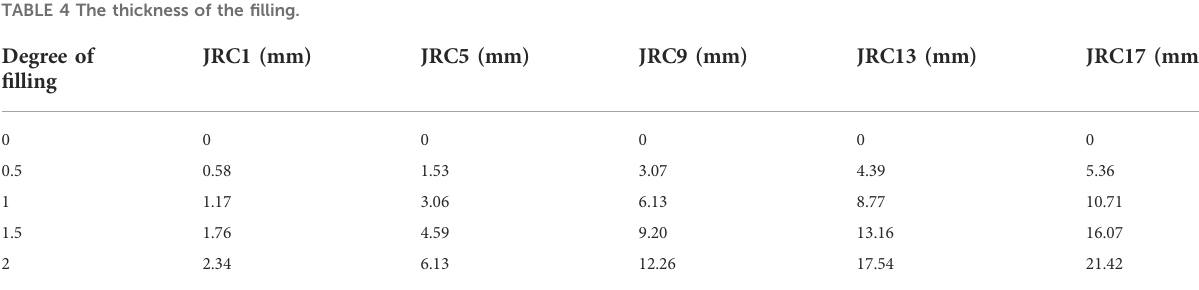
TABLE 4 The thickness of the fi